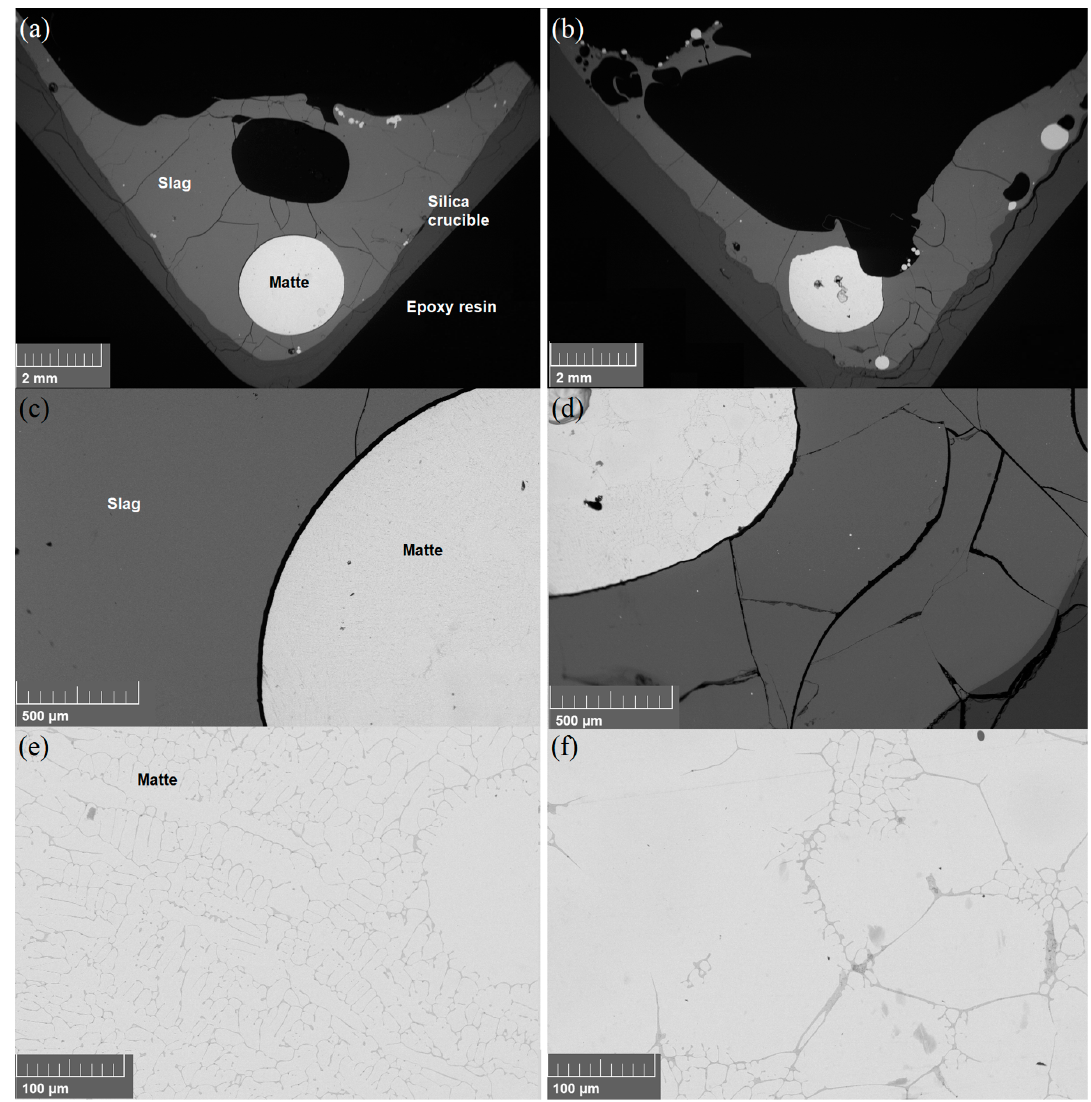
Figure 1. SEM-BSE micrographs of two samples SLAG + B (60 min, labelled ( a , c , e )) and SLAG + B + SCRAP (30 min, labelled ( b , d , f )).